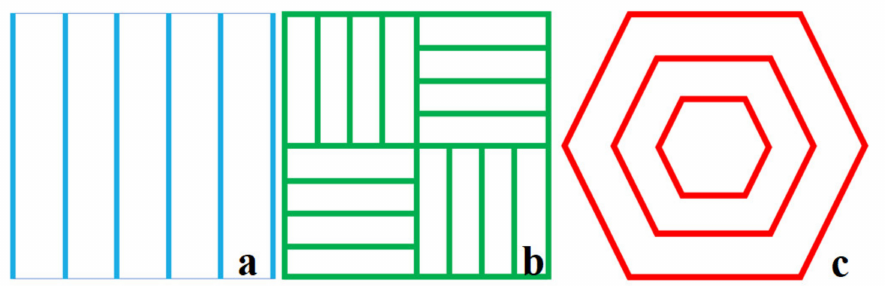
Figure 2. Graphical representation of the studied scanning strategies: ( a ) parallel stripes, ( b ) chess- board and ( c )